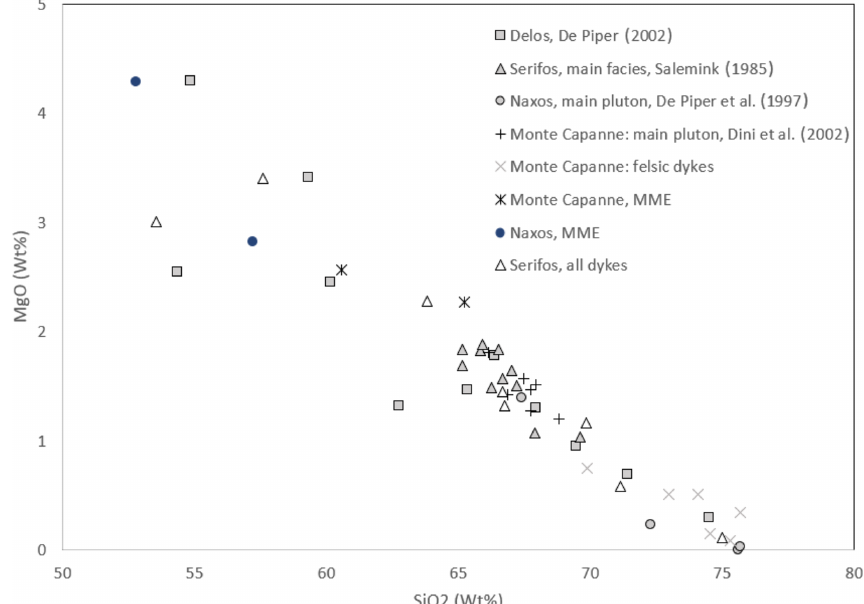
Figure A1. MgO vs. Si02 Harker diagram showing the negative correlation between whole-rock MgO and SiO 2 content for three I-type, hornblende-biotite-bearing representative Aegean granites. Data from the Delos intrusion (Pe-Piper et al., 2002), Serifos (Salemink, 1985) and Naxos (Pe-Piper et al., 1997). Mixing/mingling processes between mafic mantle-derived melts and acid magmas produce composite batholiths (Poli and Tommasini, 1990) as illustrated by the case of the island of Elba magmatic complex shown for comparison (see Dini et al., 2002, for explanation). MMEs: mafic microgranular enclaves.